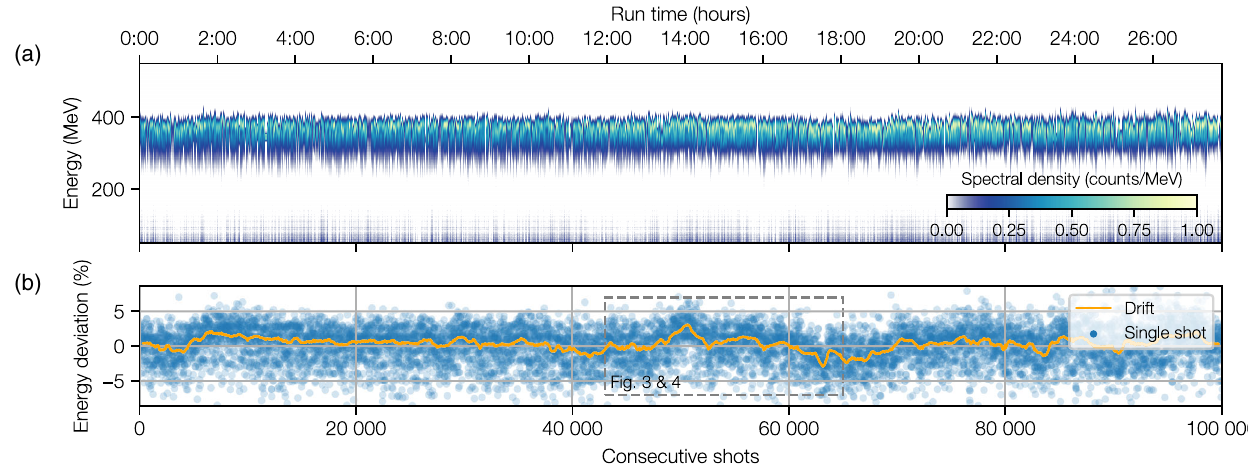
FIG. 2. Panel (a) shows the energy spectra of 100 000 consecutive laser-plasma generated electron beams. Here, each line represents one single shot. The camera images of the electron spectrometer screen are background corrected, projected onto the dispersive axis, and calibrated to a linear energy scale. The peak energy of each spectrum (dots) is shown in panel (b), together with the energy drift (solid line) calculated as the rolling average over a 6-min window, i.e., 360 shots. The percent-level energy drift can be attributed to a drift in drive laser parameters (compare Figs. 3 and